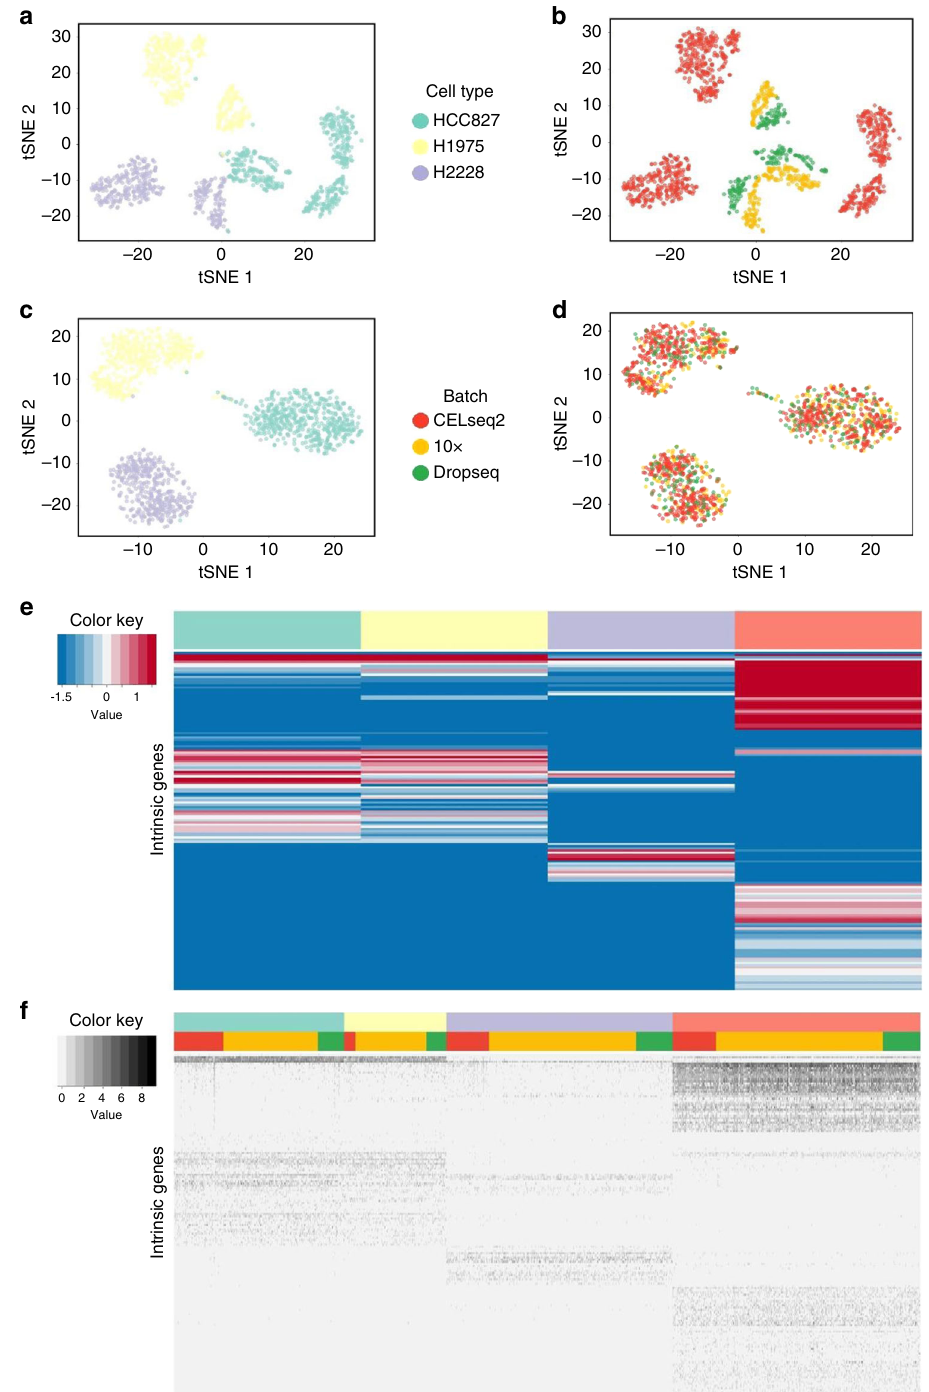
Fig. 8 Patterns of the LUAD study. a t-SNE plot of the raw count data colored by cell line (H1975, H2228 and HCC827). b t-SNE plot of the raw count data colored by protocol (CELseq2, 10x Chromium, and Dropseq). c t-SNE plot of the corrected count data by BUSseq colored by cell line. d t-SNE plot of the corrected count data by BUSseq colored by protocol. e Heatmap of log-scale mean expression levels α + β k of cell types k = 1, 2, 3, 4. Each row represents an intrinsic gene. The colored bar indicates the cell type of each column. f Heatmap of the log-scale corrected count data by BUSseq. Each row again represents an intrinsic gene, but each column corresponds to a cell. The upper colored bar indicates the estimated cell type of each cell, and the lower colored bar denotes the batch to which the corresponding cell